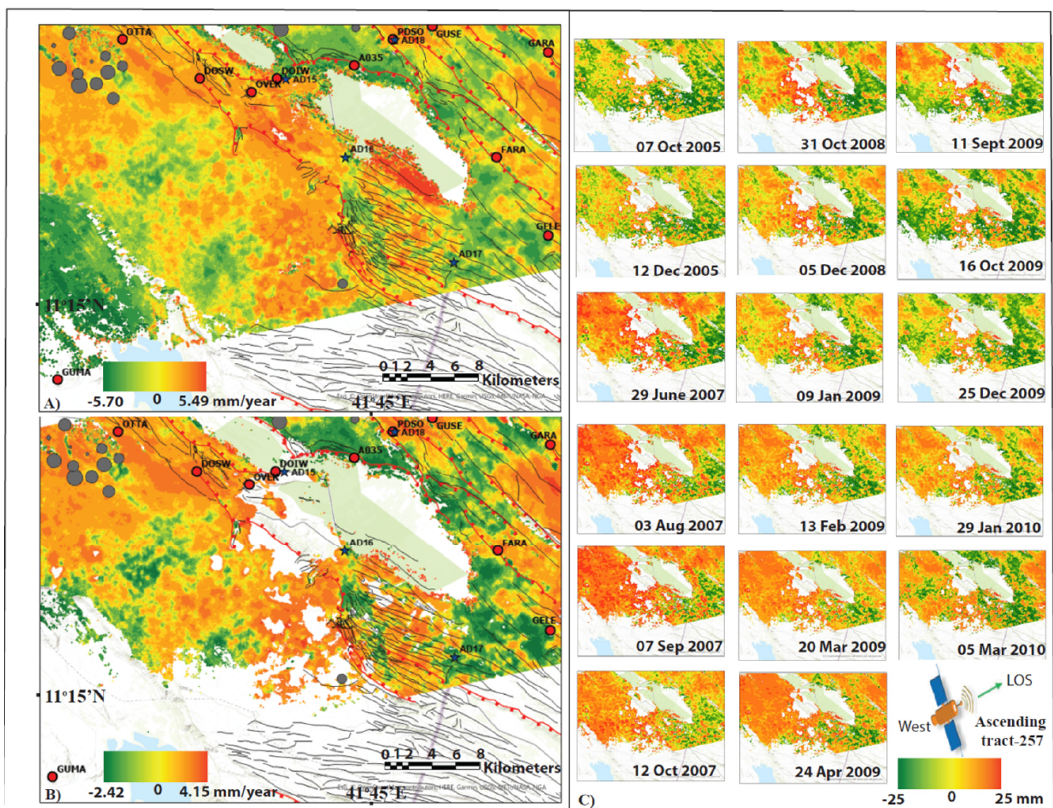
Figure 7. ( A ) The mean velocity at the LOS of the satellite for the ascending tract 257 before post- GIS processing utilizing the quality control indexes mentioned in Figure 4 for pixel multitemporal coherency; ( B ) The mean velocity at the LOS of the satellite after extracting the noisy pixels applying the quality control indexes criteria; ( C ) Time-series displacement measurement corresponding to the measurement (in mm/year) of each scene with respect to the 9 January 2007 master image acquisition. The different colors and symbols represent displacement (in mm/year) along the LOS.